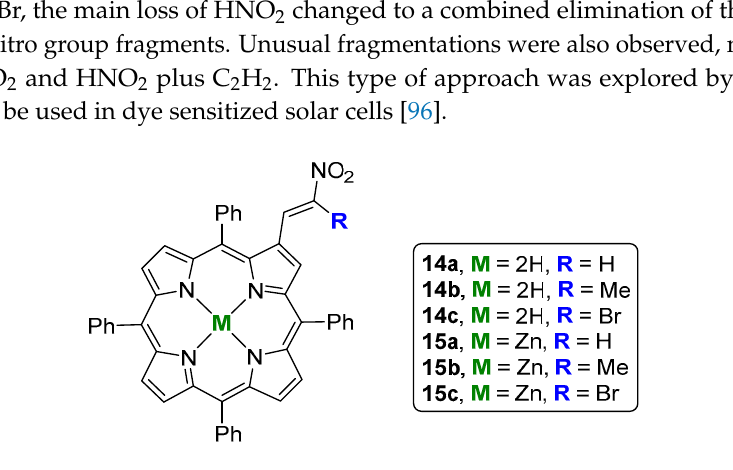
Figure 6. β -Nitroalkenyl-substituted meso -tetraphenylporphyrins [95].